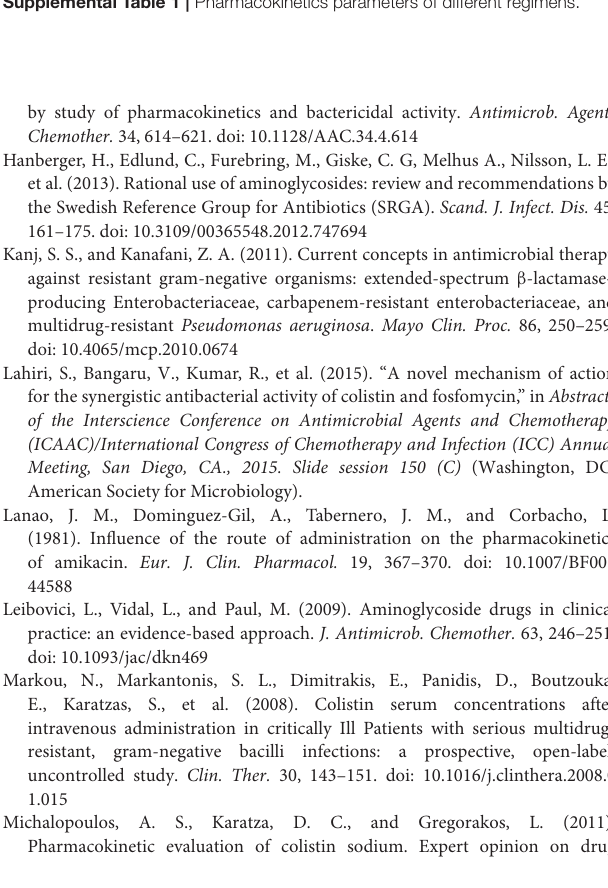
Supplemental Figure 1 | Pharmacokinetics Auto Simulation System 400. Supplemental Figure 2 | The time-concentration of antibiotics in the Pharmacokinetics Auto Simulation System 400. Supplemental Figure 3 | The sketch of pharmacodynamic parameters. MKD, Maximum Kill Down; MKT, Maximum Kill Time; AAKC, Area Above Kill Curve; RT,